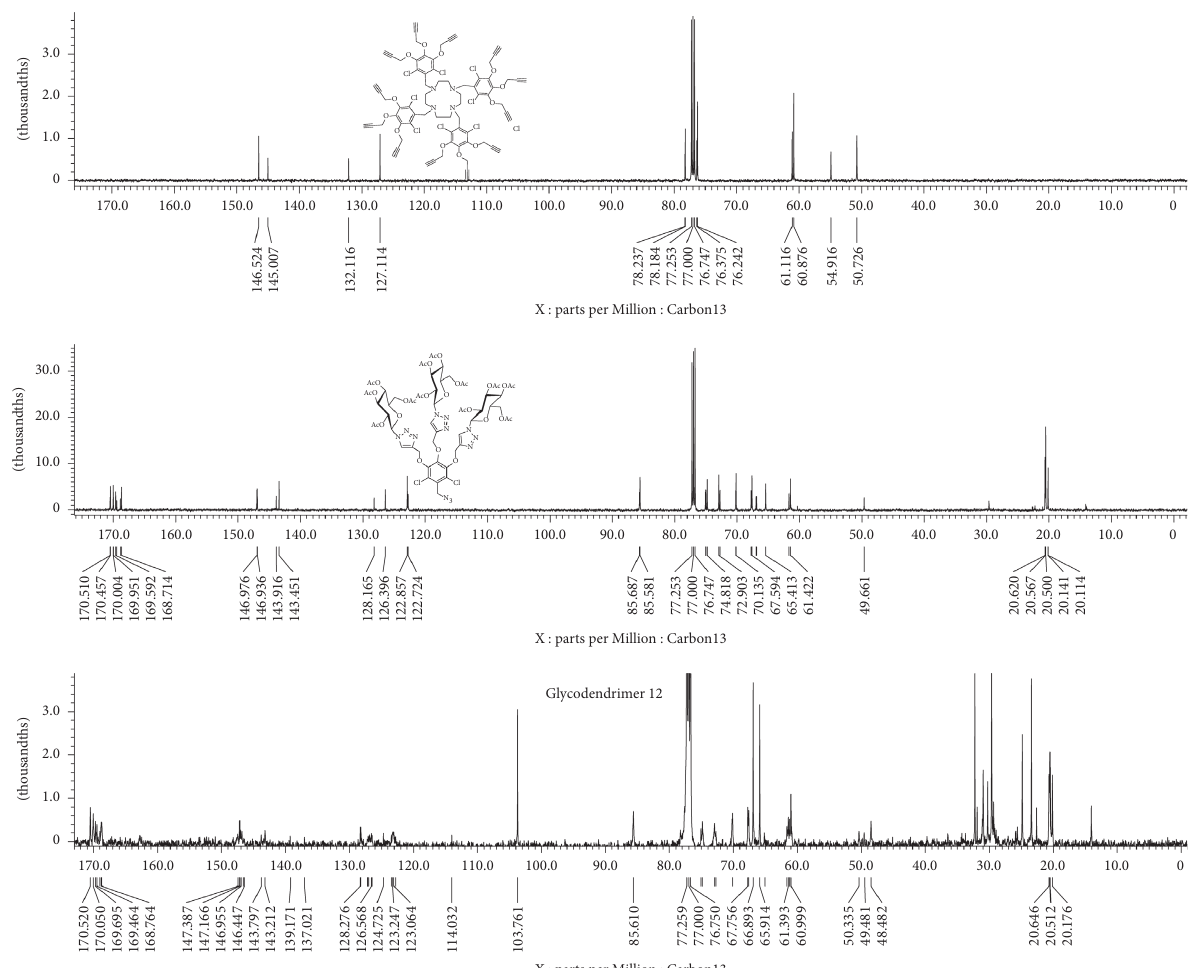
Figure 4: 13 C-NMR spectra of core 7, dendritic wedge 11, and chlorine-containing glycodendrimer 12.